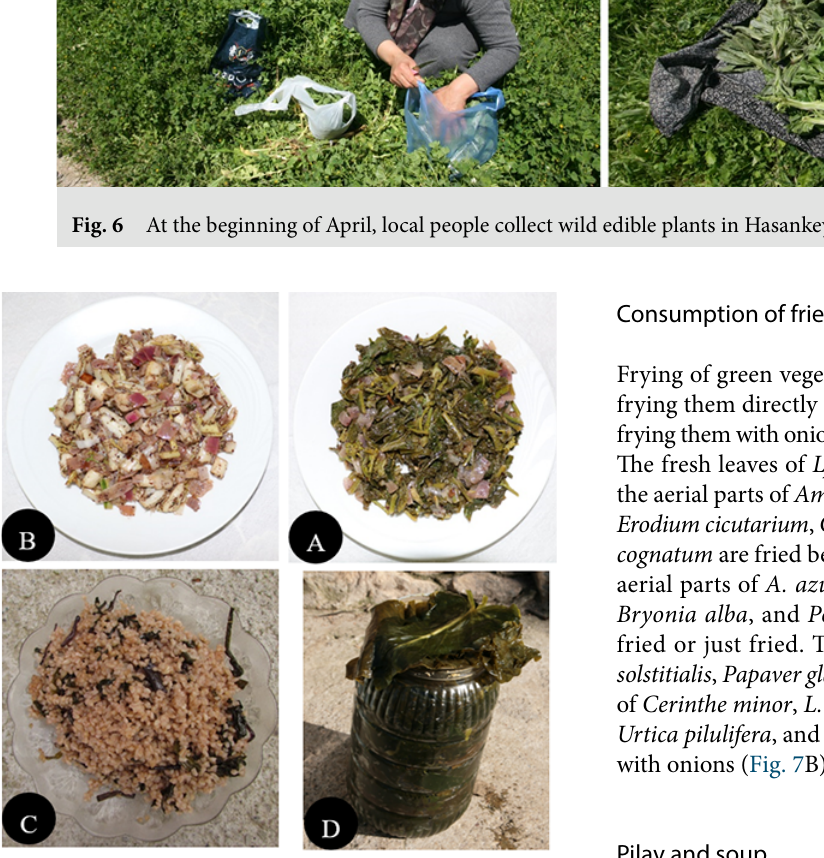
Fig. 7 Dishes prepared from wild edible plants. ( A ) Fried aerial parts of Gundelia tournefortii ; ( B ) the fried leaves of Sinapis arvensis ; ( C ) Pilav of Allium kharputens ; ( D ) the brined leaves of Arum rupicola